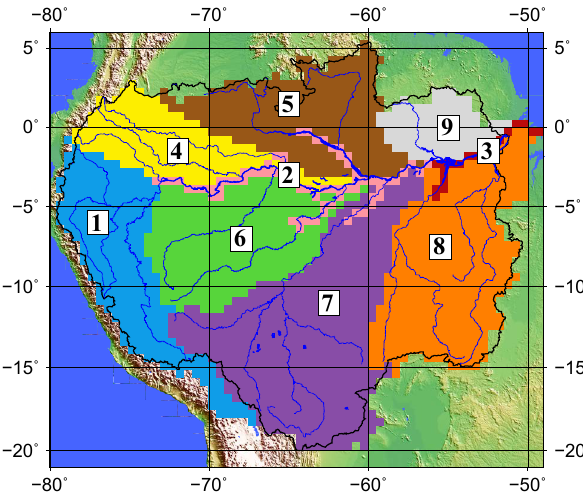
Figure 2. Map of hydro-geomorphological zones defined over the Amazon